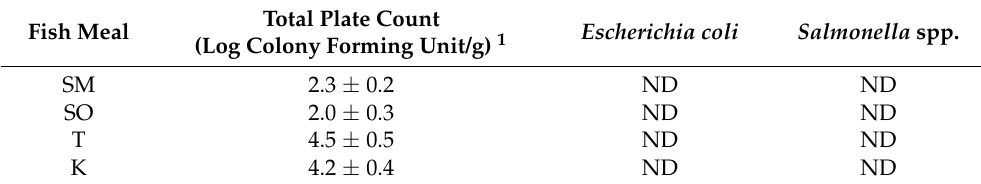
Table 2. Total plate count and occurrence of Salmonella and E. coli in fish meal samples from different feed mills. Total Plate Count Escherichia coli Salmonella Fish Meal (Log Colony Forming Unit/g) 1